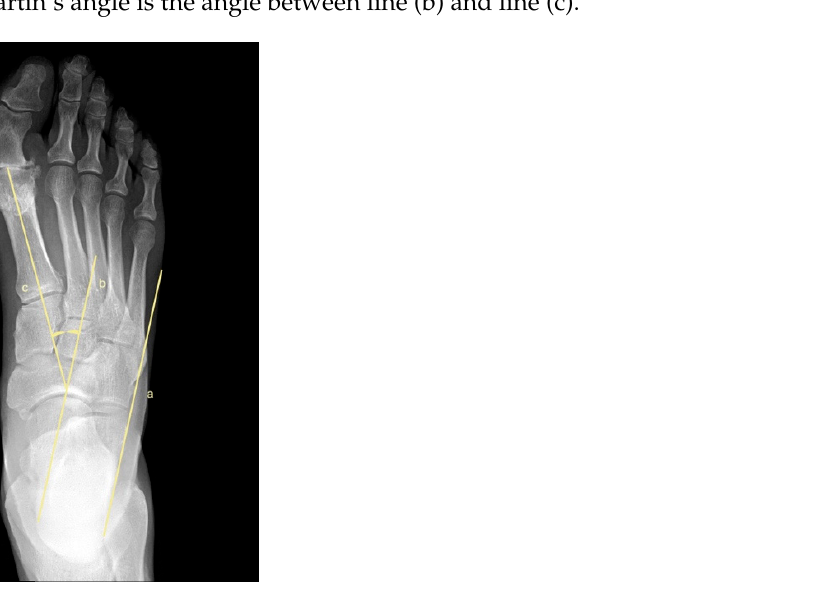
Kilmartin’s angle [36], Figure 8, is measured between a line parallel to the lateral border of the calcaneum and the 1st metatarsus axis. Line (a) is parallel to the lateral border of the calcaneum. Line (b) is a line parallel to line (a); line (c) is the axis of the 1st metatarsal. Kilmartin’s angle is the angle between line (b) and line (c).